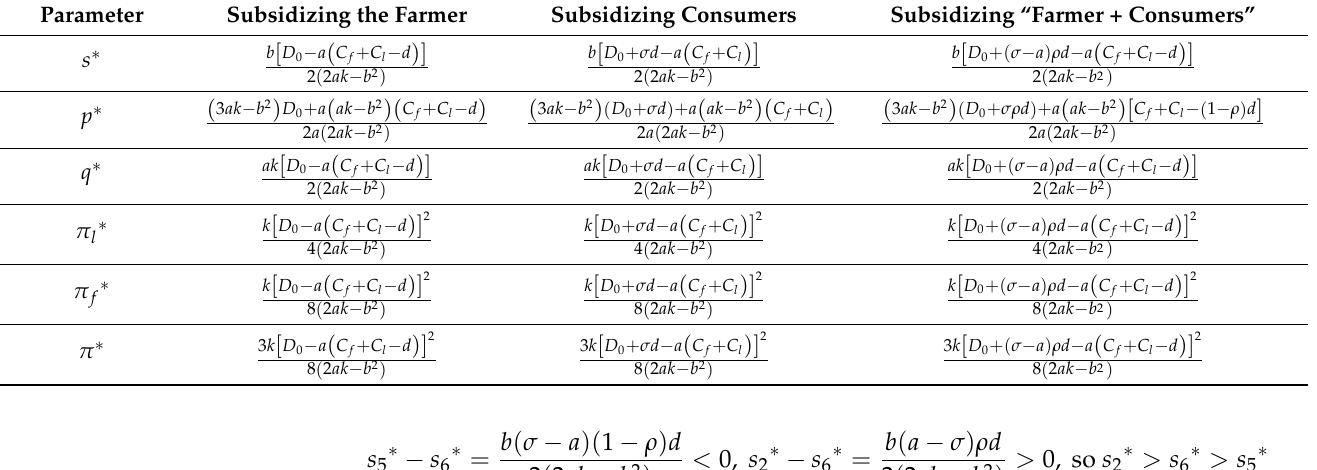
Table 4. Comparison of government subsidies to consumers and subsidies “farmer +